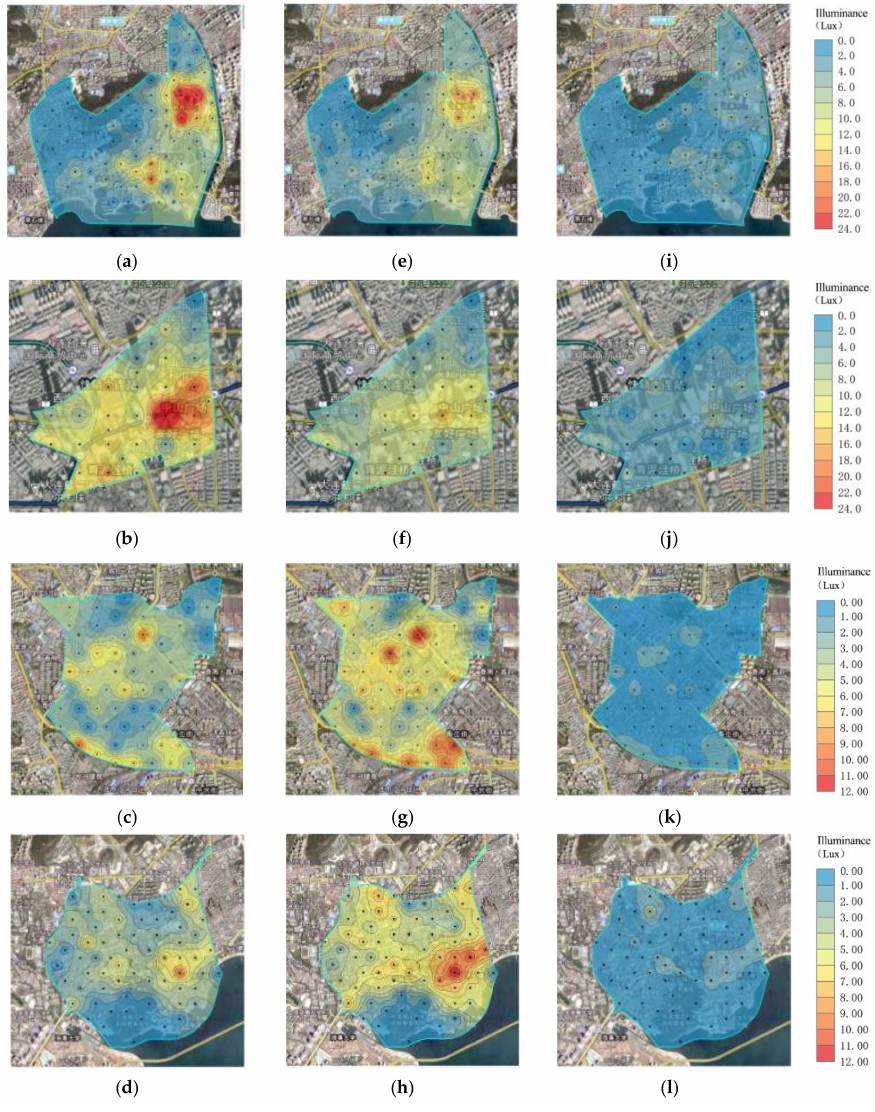
Figure 8. Illumination distribution in three directions of high value area. ( a ) Xinghaiwan upper window; ( b ) Qingniwa upper window; ( c ) Chunliu upper window; ( d ) Heishijiao upper window; ( e ) Xinghaiwan horizontal window; ( f ) Qingniwa horizontal window; ( g ) Chunliu horizontal window; ( h ) Heishijiao horizontal window; ( i ) Xinghaiwan lower window; ( j ) Qingniwa lower window; ( k ) Chunliu lower window; ( l ) Heishijiao lower